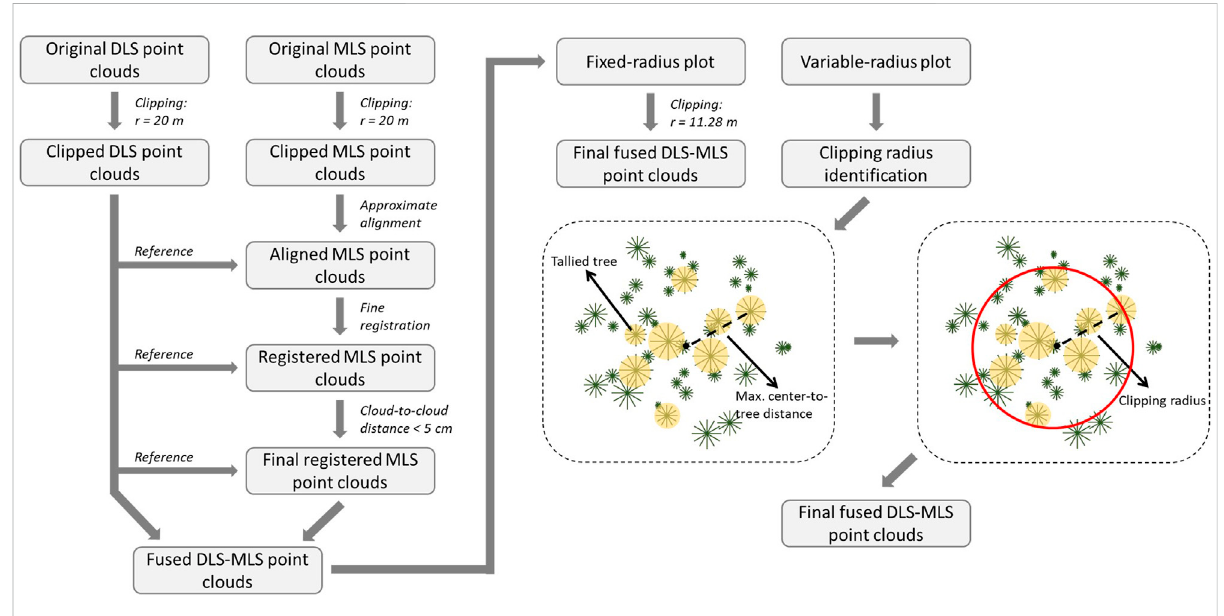
FIGURE 4 The work fl ow of point cloud registration, fusion, and matching with fi xed or variable-radius fi eld